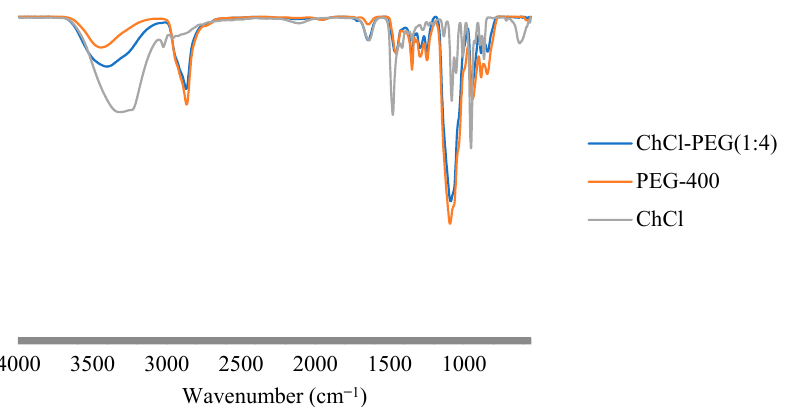
Figure 6. Comparison of ChCl-PEG (1:4) FTIR graph with its respective pure components.